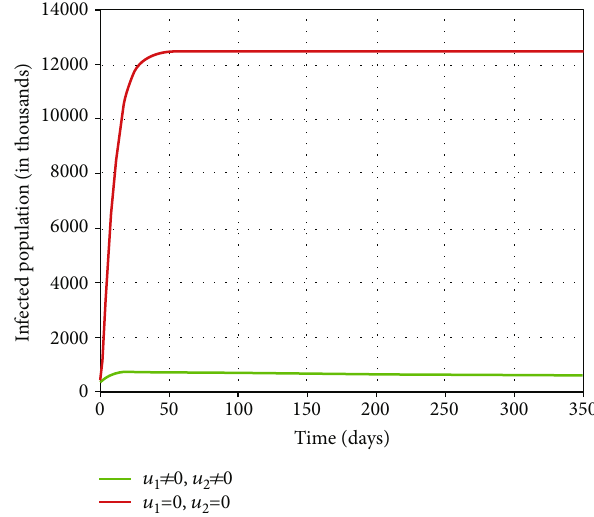
Figure 14: Susceptible individuals with and without prevention strategy u 1 :